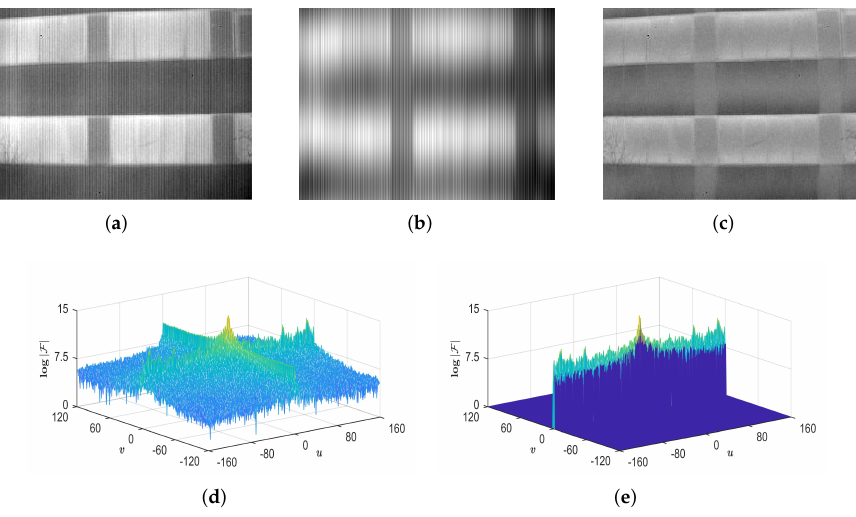
Figure 2. Example of image representation using the stripe frequency band (SFB). ( a ) Real IR image with stripe nonuniformity noise; ( b ) Noise component reconstructed by the SFB; ( c ) Structures in the remaining component; ( d ) Amplitude spectrum of ( a ); ( e ) SFB separated from ( d